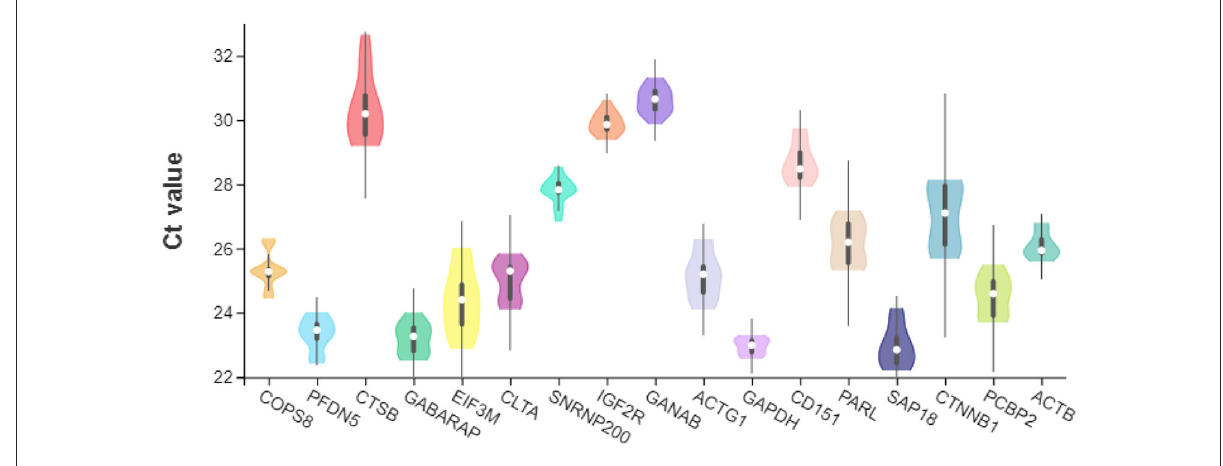
FIGURE3 Violin plot of Ct values of 17 candidate reference